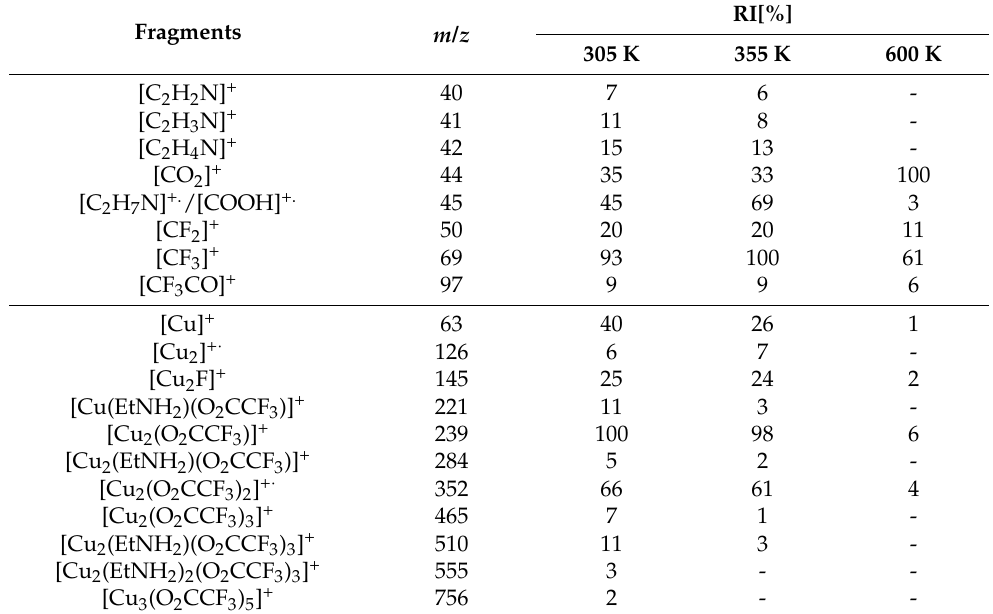
Table 2. Mass spectrometry EI MS data of [Cu 2 (EtNH 2 ) 2 ( µ -O 2 CCF 3 ) 4 ] ( 1 ). Fragments